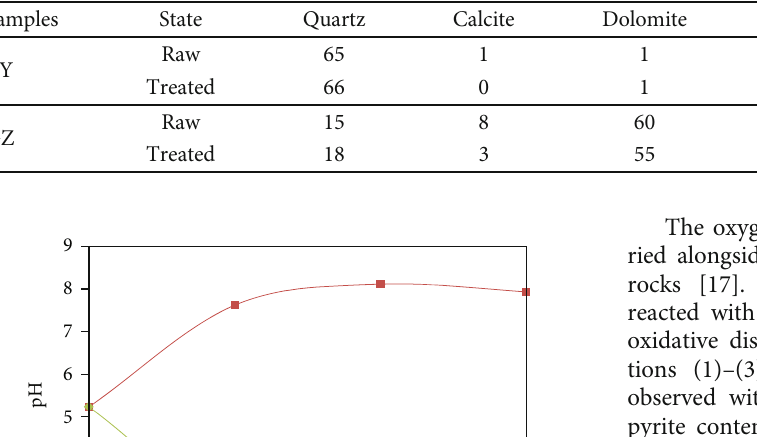
Table 3: Mineralogical compositions of the shale samples before and after slick water treatment (%).